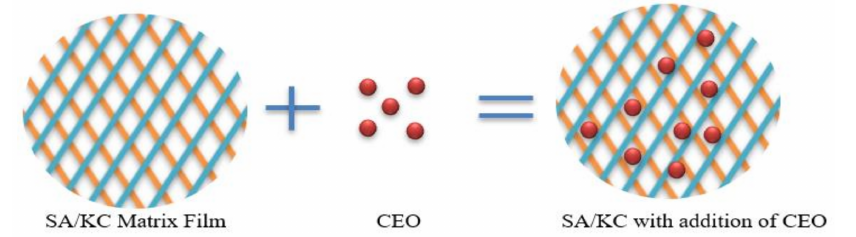
Figure 7. The scheme of incorporated eugenol group contained in clove essential oil (CEO) in the film